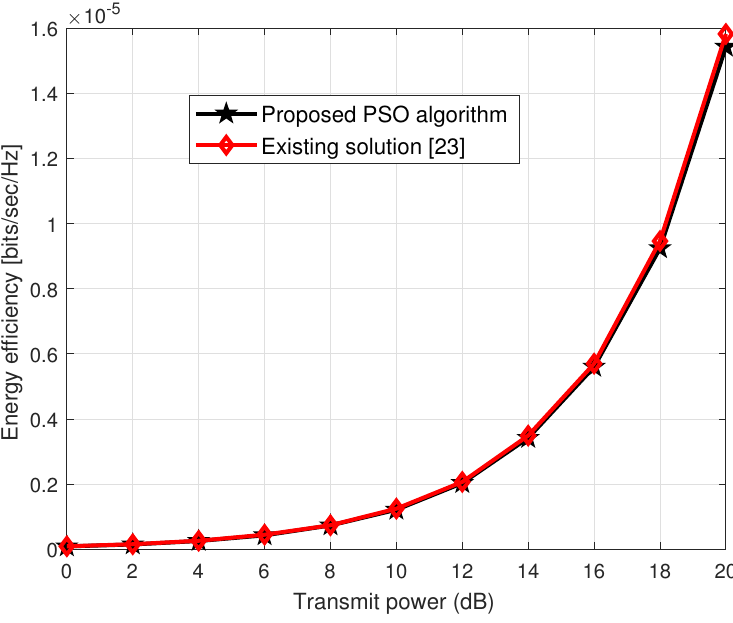
Figure 9. Energy efficiency performance over the wide ranges of transmit